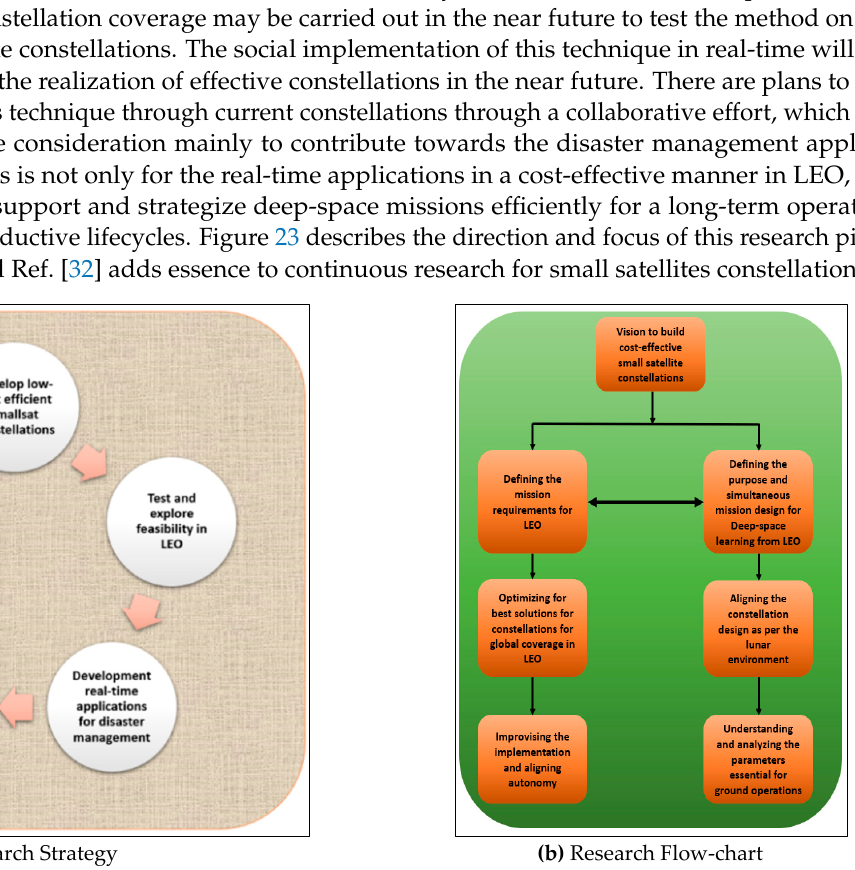
Figure 23. Research direction and ethos of this paper.